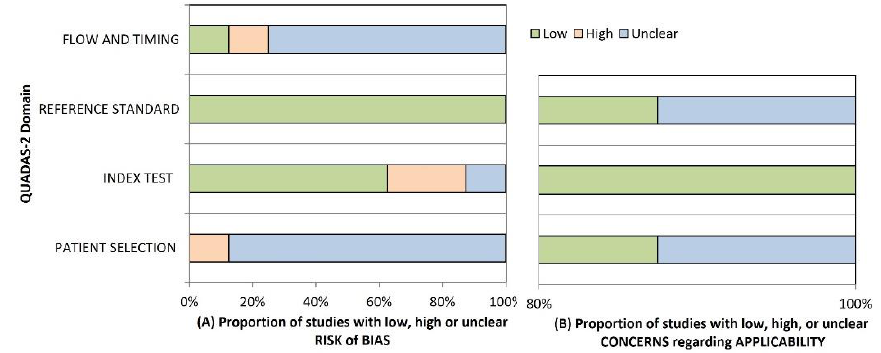
Figure 2. QUADAS-2 Domain. ( A ) Risk of bias; ( B ) Concerns regarding applicability.